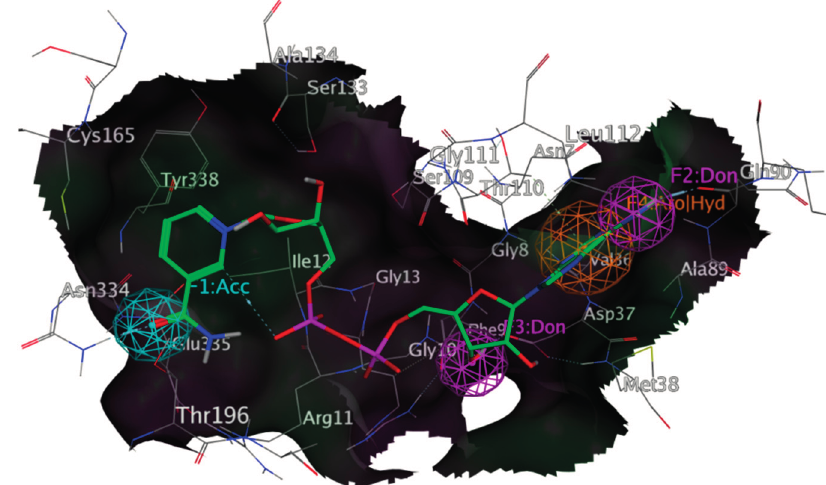
Figure 7. Representation of the pharmacophore based on an NAD + binding site from Tb GAPDH (PDB-ID 2X0N), co-crystallized NAD + shown with green carbon atoms; rendered surface colored according to lipophilicity, green indicating high, purple low lipophilicity; aromatic features in orange; H-bond donor features in purple; H-bond acceptor features in cyan. Interactions employed as features were calculated with MOE (“ligand interactions” algorithm); exclusion spheres are